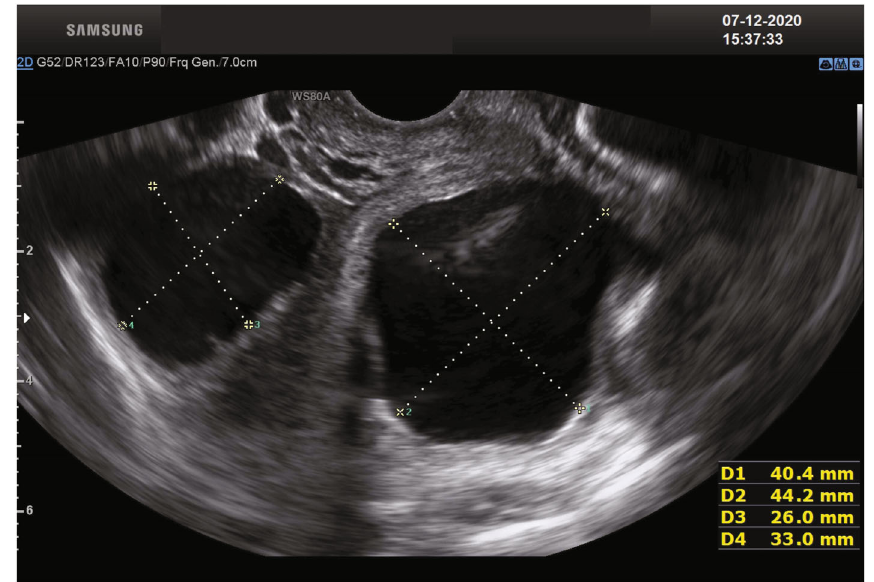
Figure 1: Dilated Tubes on the left side.